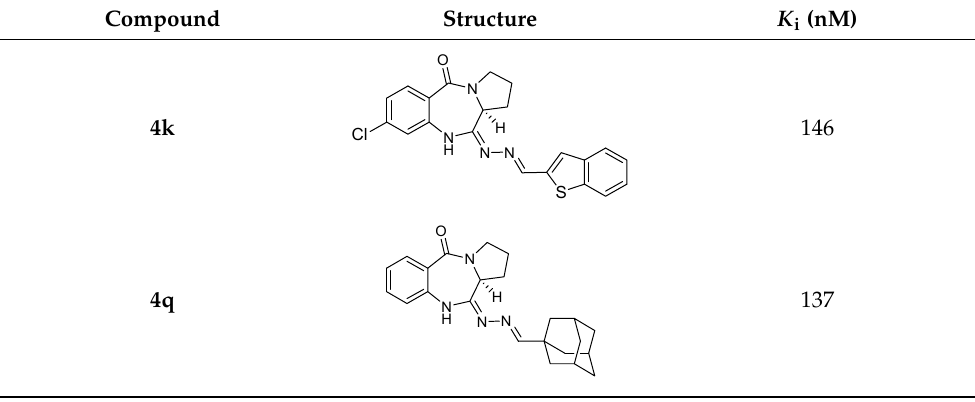
Table 2. Cannabinoid receptor binding assays of the lead compounds against CB2.